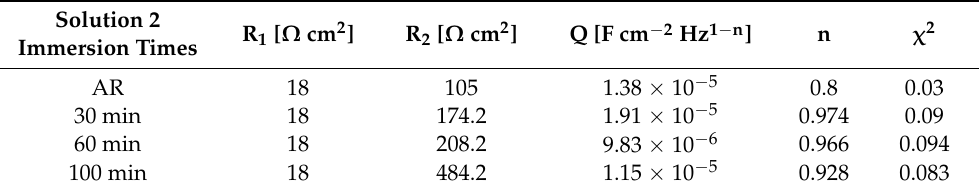
Table 7. Results of the fitting of the experimental data for the samples obtained with solution 2 at ambient